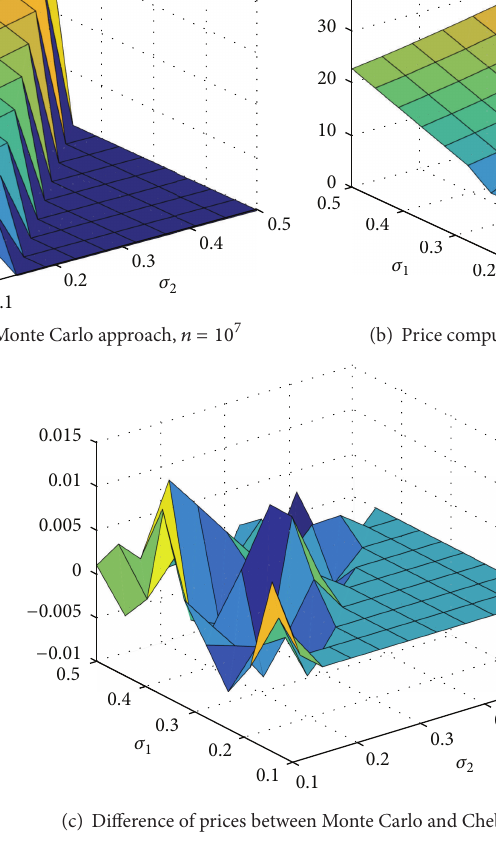
Figure 4: Prices of a spread contract with log-return volatilities between 10% and 50% under the benchmark parametric set. (c) Difference between prices obtained for both methods. We consider, without loss of generality, the case 𝜎 1 ≥ 𝜎 2